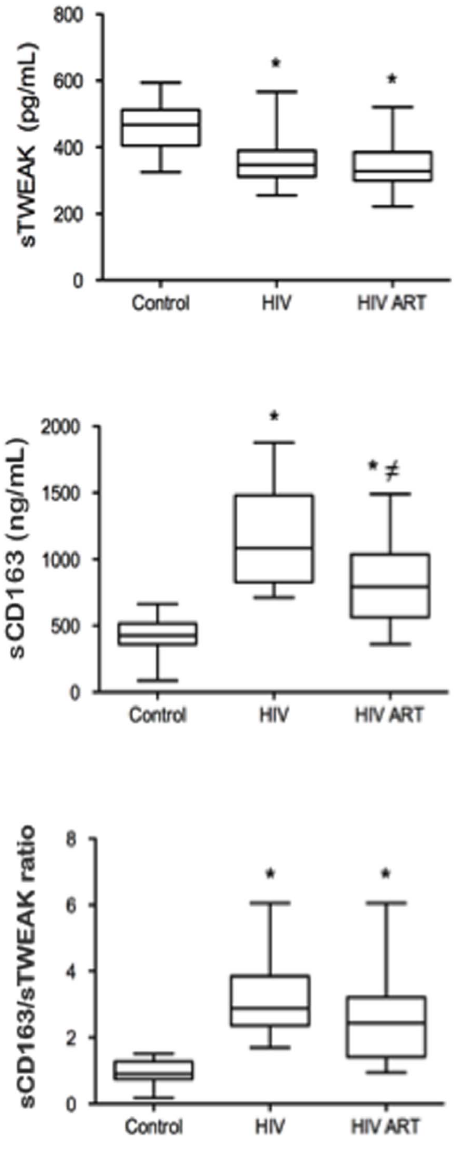
Figure 1. Comparison of sTWEAK, sCD163 and the sCD163/ sTWEAK ratio. sTWEAK, sCD163 and the sCD163/sTWEAK ratio in control subjects and HIV patients at baseline and after ART. * P , 0.05 vs. control, ? P , 0.05 vs. HIV baseline.